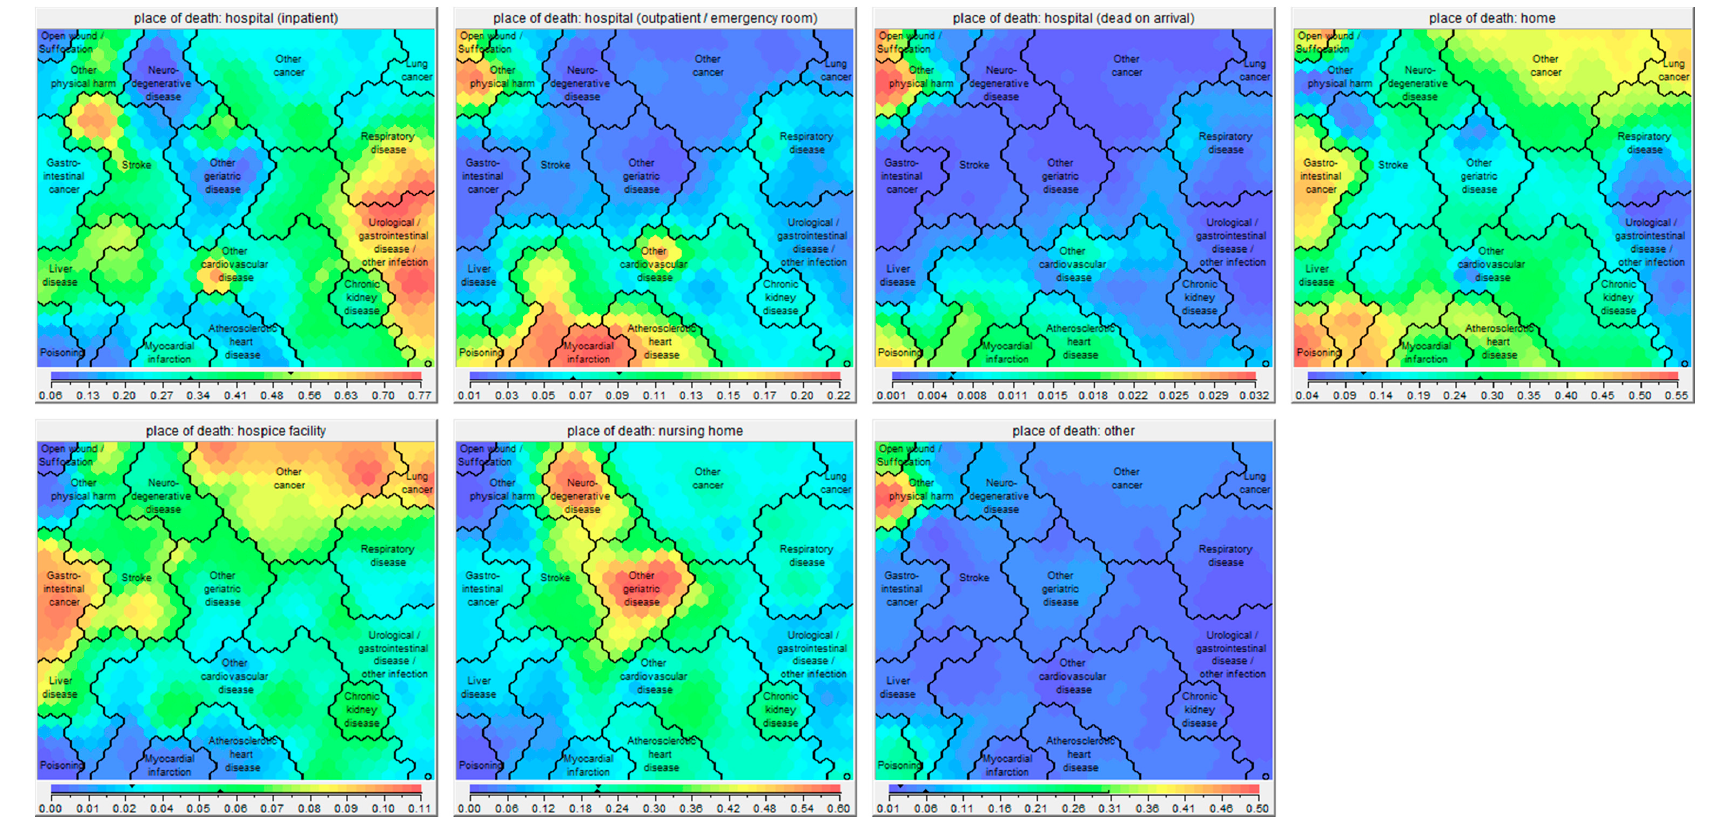
Figure 3. Self-organizing maps showing the place of death (hospital, home, hospice facility, nursing home, other) of the 16 clusters. Red parts of the map consist of high percentages of persons dying in the indicated place, whereas blue parts consist of low percentages of persons dying in the indicated place. The exact percentages are given in the bar under the respective map picture.